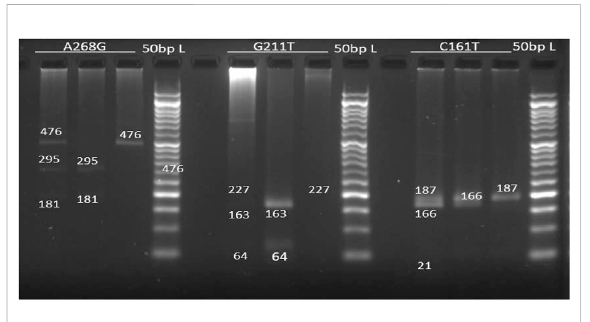
FIGURE 1 Electrophoresis gel image patterns of UGT2B7 (A268G, G211T, C161T) gene after digestion with BglII, MbiI, BstNI enzymes respectively (L): 50bp Ladder, Lane 1): homozygosity for variant allele, Lane(2): homozygosity for common allele, Lane 3): heterozygosity.